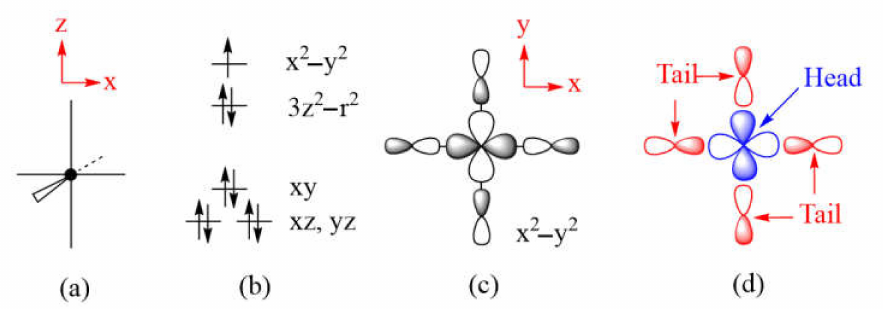
Figure 6. ( a ) An axially elongated CuL 6 octahedron. ( b ) The electron configuration of a Cu 2+ (d 9 ) ion at an axially elongated octahedral site. ( c ) The magnetic orbital of the Cu 2+ (d 9 ) ion at an axially elongated octahedral site, which is contained in the CuL 4 equatorial plane. ( d ) The head and tails of the magnetic